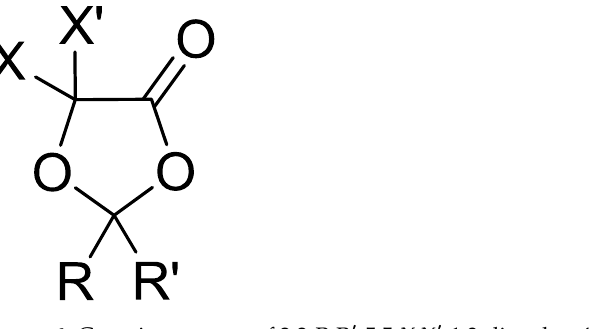
Figure 6. Generic structure of 2,2-R,R ′ -5,5-X,X ′ -1,3-dioxolan-4-one compounds.